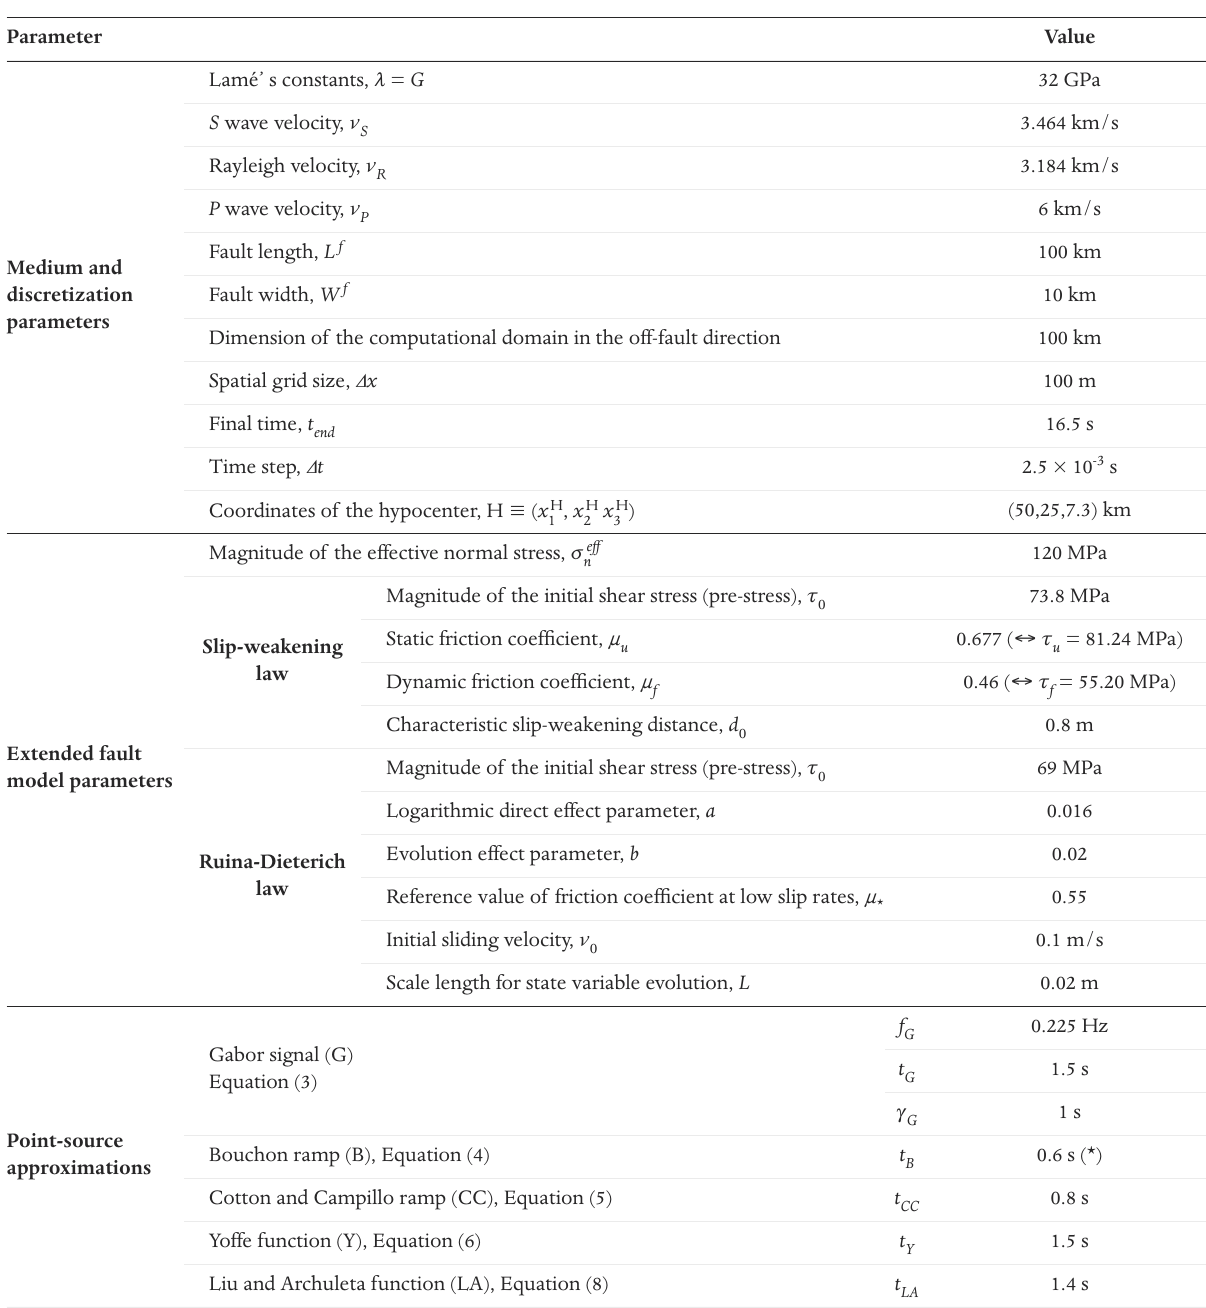
Table 2. Parameters adopted in the present study. (*) We also apply a time shift of −0.7